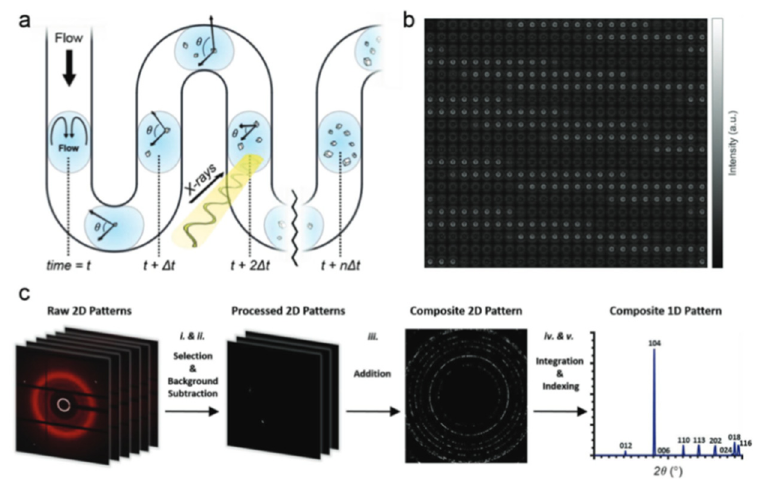
Figure 6. ( a ) Schematic image of the experimental set-up with an X-ray beam held at the fixed position. ( b ) Images of 500 consecutive diffraction patterns of the droplets during the calcite particles formation. ( c ) Diagram of the 2d patterns processing and analysis; ( i ) frames containing oil are discarded; ( ii ) background are subtracted from the selected frames; ( iii ) processed frames are combined to obtain a composite diffraction pattern; ( iv , v ) the composite pattern is integrated to obtain the diffraction profile. Image reproduced from Levenstein, M. A. et al., with permission from Adv. Funct. Mater. [55].